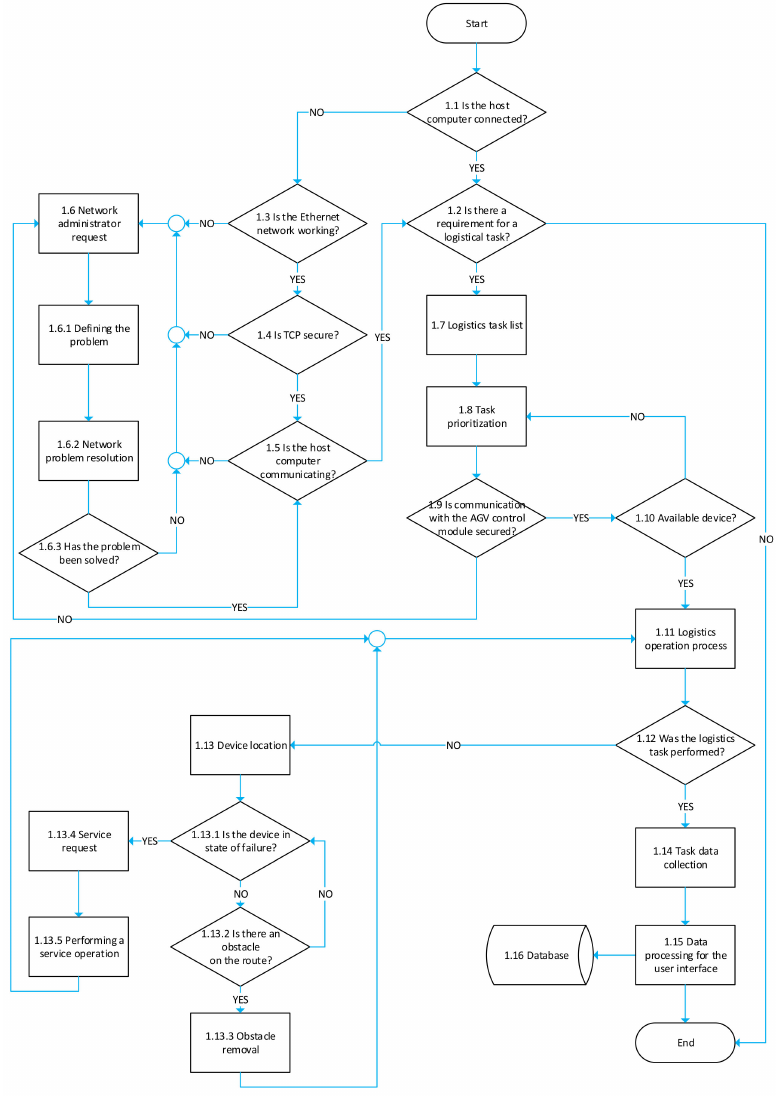
Figure 2. The algorithm of the control system for